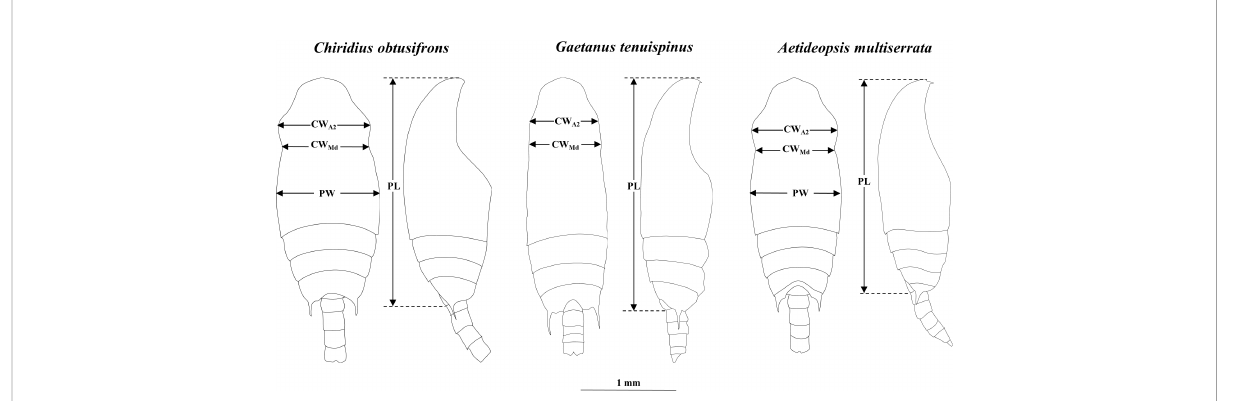
FIGURE 2 Diagrams showing body size measurements: cephalosome width at antenna (CW A2 ), cephalosome width at mandible (CW Md ), prosome width at middle of the prosome (PW), and prosome length (PL) for Chiridius obtusifrons (left), Gaetanus tenuispinus (centre) and Aetideopsis multiserrata (right). Scale bar represents 1